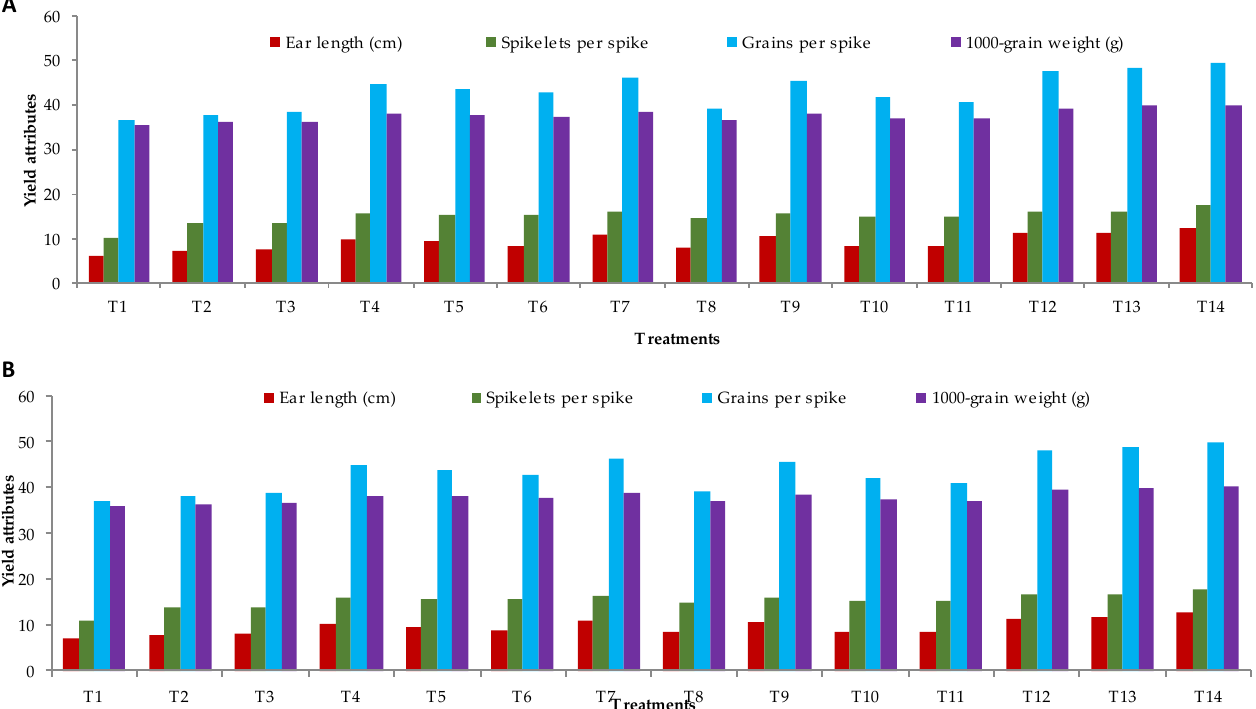
Figure 4. Yield attributes (ear length, spikelets per spike, grains per spikelets and 1000 grain wt) during 2017 – 2018 ( A ) and 2017 – 2018 ( B ).